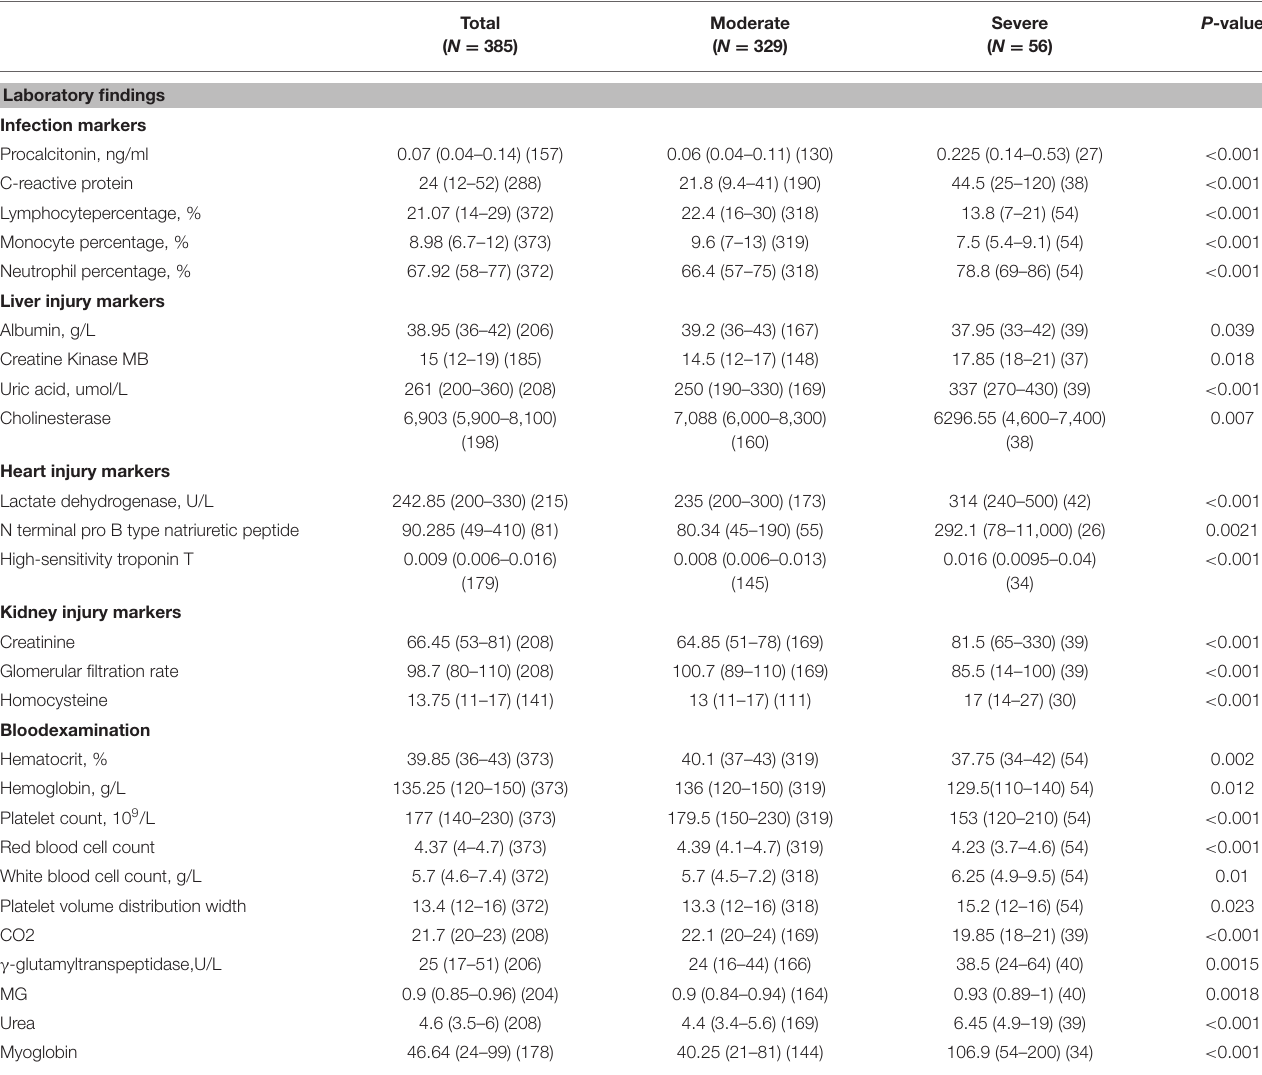
TABLE 1 | Comparing laboratory findings between moderate and severe COVID-19 patients.